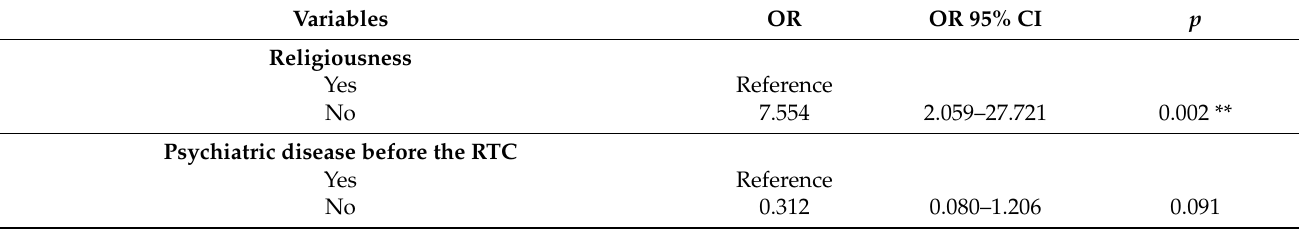
Table 11. The multivariable regression model for PTSD symptoms at 6-month follow-up. Variables